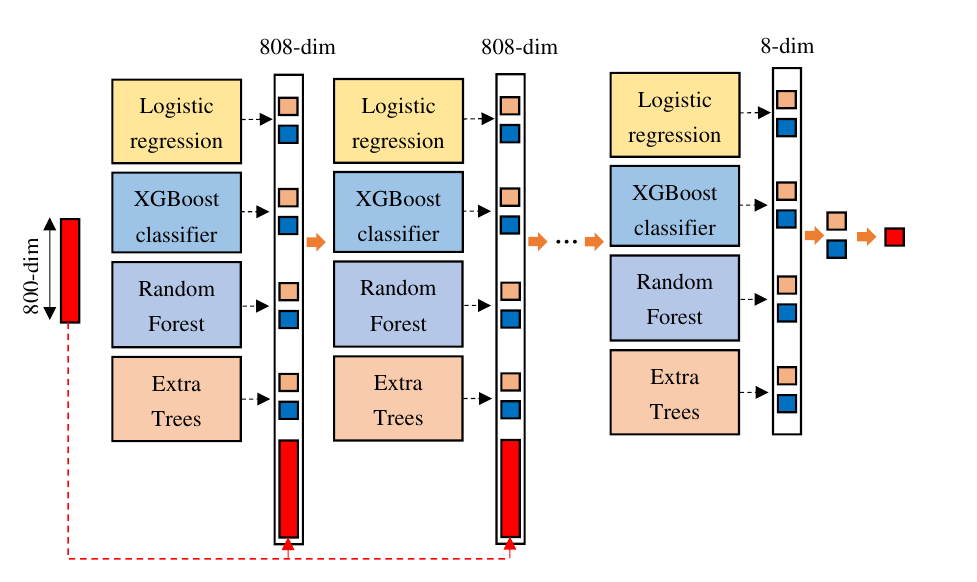
Figure 4. Deep forest with cascade forest